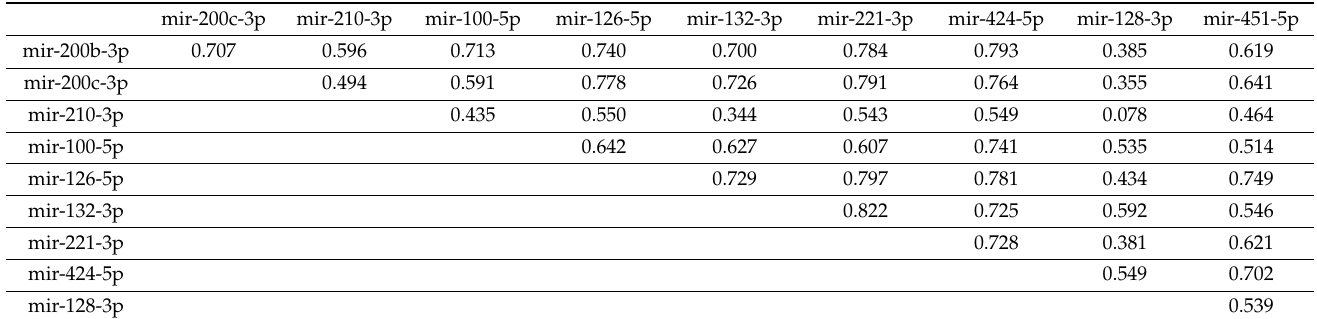
Table 1. Inter-miRNA correlation (Spearman rank correlation coefficients).